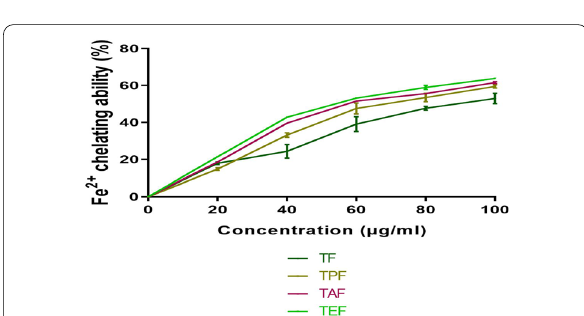
Fig. 3 Fe 2 + chelating ability of native and modified tacca flour.